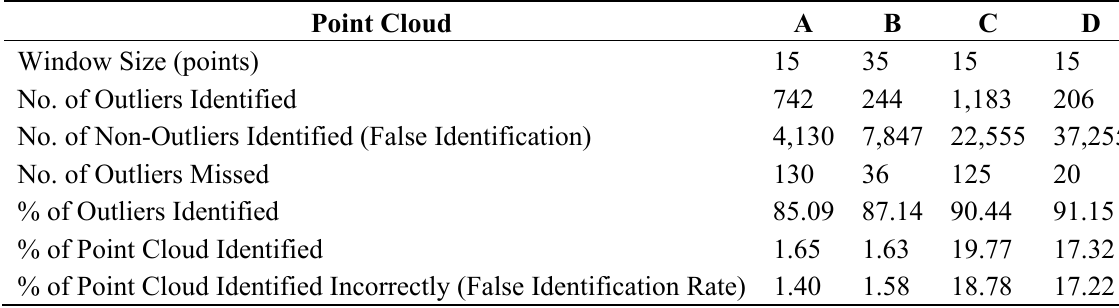
Table 3. Results from trials conducted using XYZ coordinates in the Moving Fixed Interval Smoother (MFIS) on point clouds A, B, C and D.